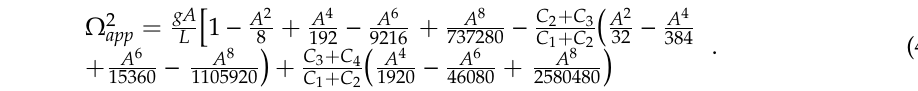
Figure 20. Comparison between the approximate solution (50) and numerical integration results for Figure 21. Phase plane for A = 0.4, L = 0.6.